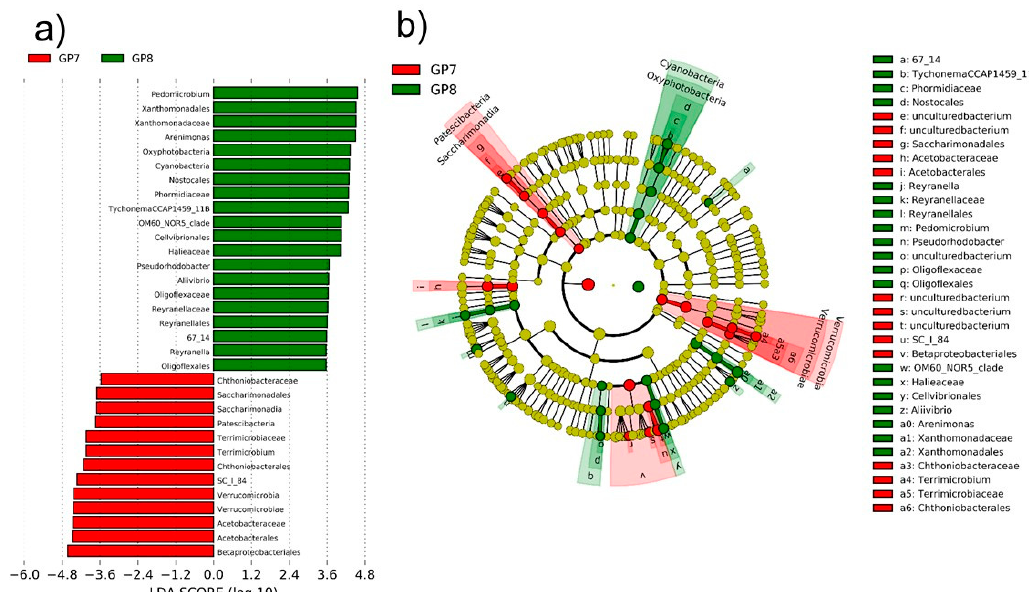
Figure 4. Significantly different bacterial taxa abundances between two sample sites ( a ) and phylogenetic location of significantly dominant taxa ( b ) according to linear discriminant analysis score over 2 in a LEfSe analysis.